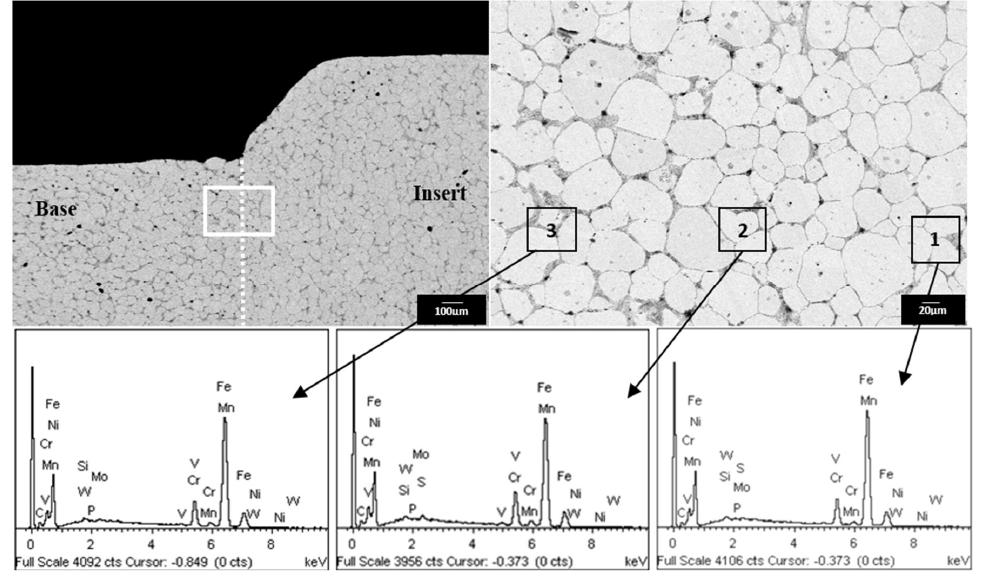
Figure 9. SEM micrographs of thixojoined part at 1300 °C with EDX of point ( 1 ) for base metal, ( 2 ) for diffusion area and ( 3 ) for insert.